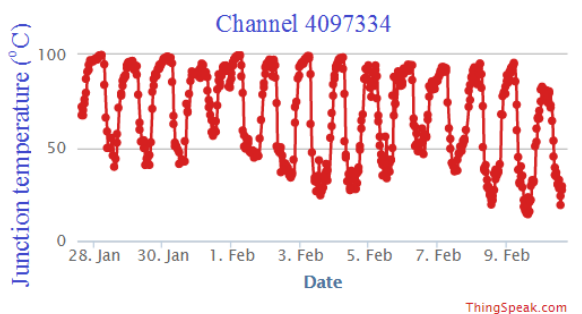
Figure 21: Junction temperature ( ∘